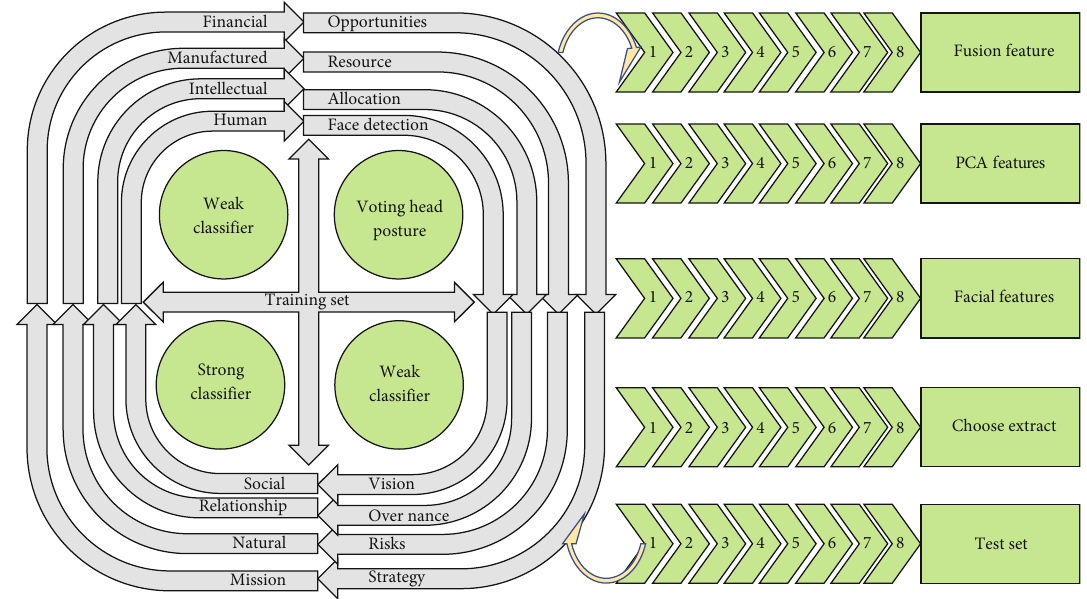
Figure 2: Integrated classi fi er